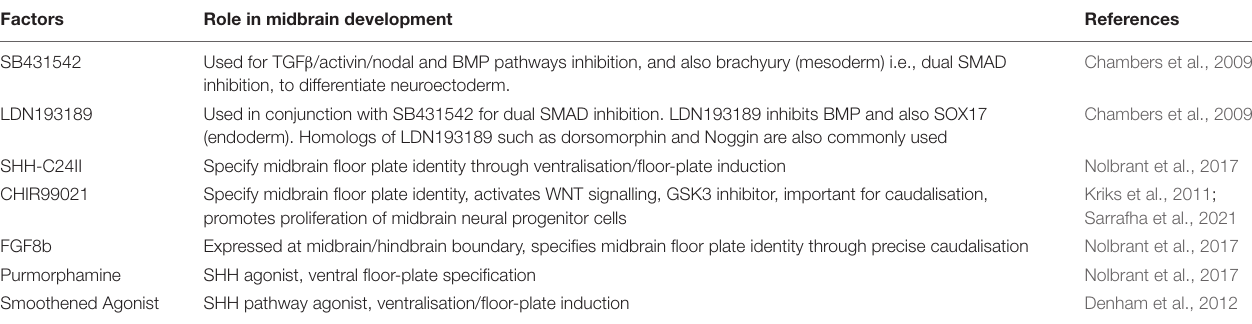
TABLE 1 | Factors used in the derivation of midbrain cultures from human embryonic stem cells (ESC) and induced pluripotent stem cells (iPSC).